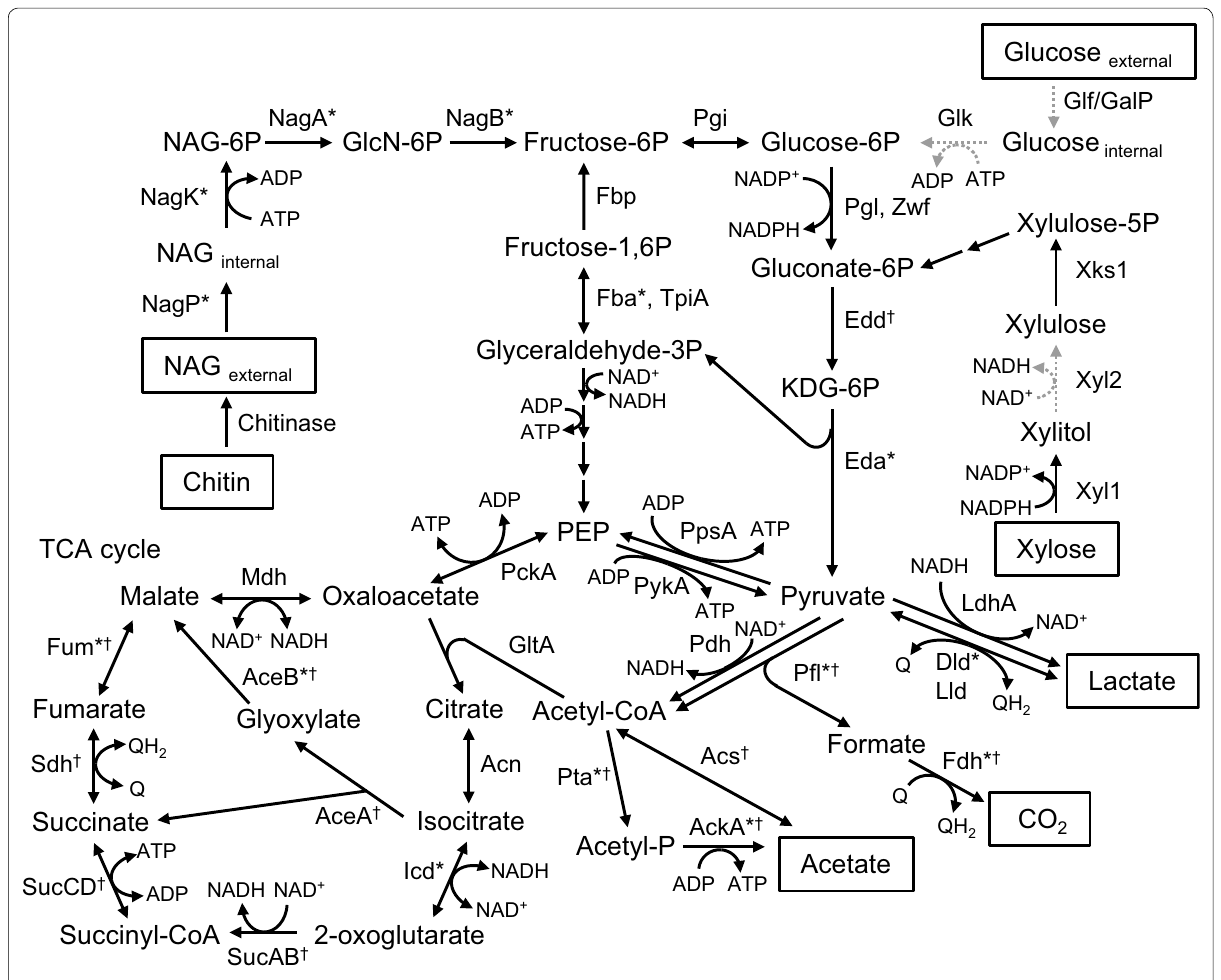
Fig. 1 Catabolic pathways in S. oneidensis MR-1. Growth substrates and end metabolites are highlighted with boxes, while missing steps are indicated with gray dashed arrows. *Enzymes whose gene expression is regulated by the Arc system (Gao et al. 2008); † enzymes whose gene expression is regulated by the cAMP/CRP system (Charania et al. 2009). NAG: N -acetylglucosamine; NAG-6P: N -acetylglucosamine-6-phosphate; KDG-6P: 2-keto-3-deoxygluconate 6-phosphate; PEP: phosphoenolpyruvate; Q: quinone; QH 2 : quinol; NagP: N -acetylglucosamine transporter; NagK: N -acetylglucosamine kinase; NagA: N -acetylglucosamine-6-phosphate deacetylase; NagB: glucosamine/fructose-6-phosphate aminotransferase; Fbp: fructose-1,6-bisphosphatase; Fba: fructose-bisphosphate aldolase; TpiA: triosephosphate isomerase; Pgi: glucose-6-phosphate